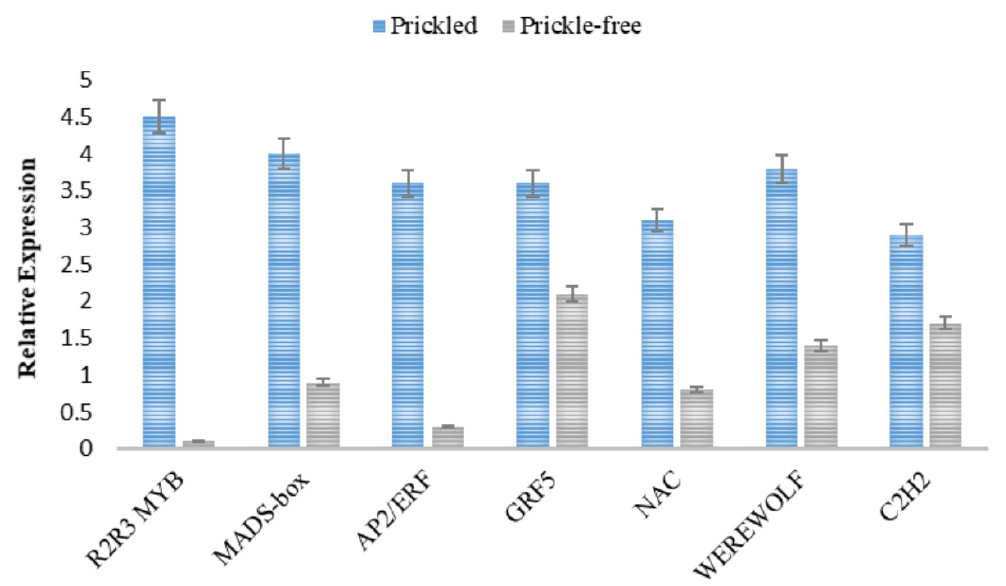
Figure 6. Relative expression patterns of plant development-related transcription factors (TFs) in prickled and prickle-free epidermis. Error bars represent SE of means of triplicates.